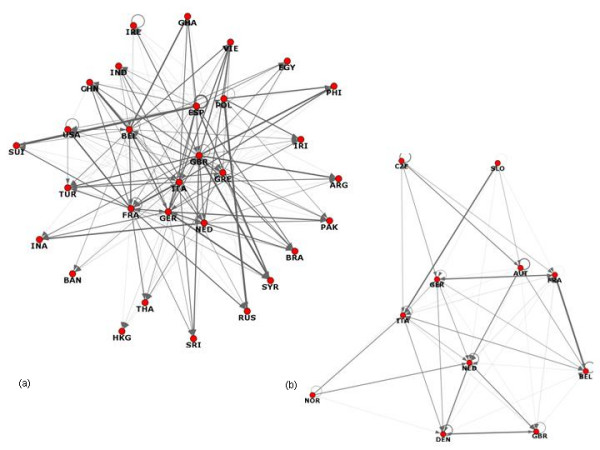
The innermost (5th) layer of the k-core decomposition based on in-degrees (a) and (b) out-degrees.